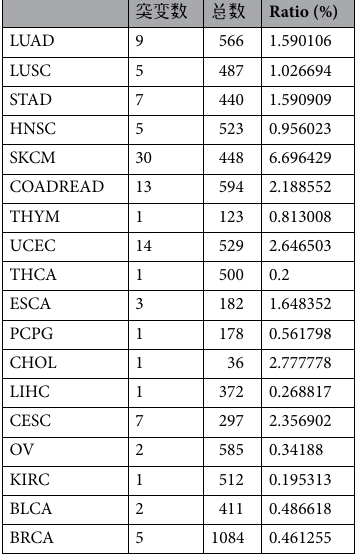
Table 1. The MEK1 total mutation frequency obtained from